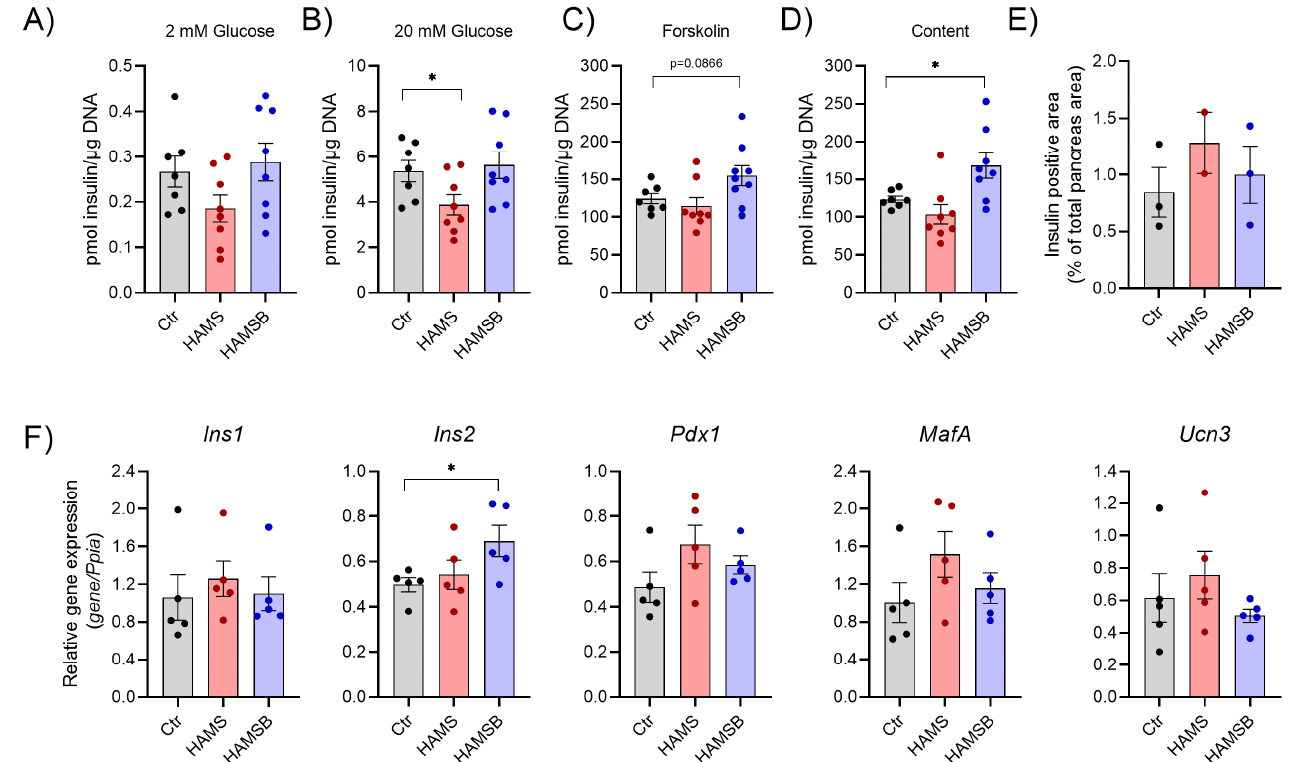
Figure 5. Islet function and gene expression. Insulin secretion was measured from islets of db/db mice fed three different diets: Ctr, HAMS or HAMSB for 5 weeks. The day after islet isolation, insulin secretion was measured by static batch incubations in response to 2 mM glucose ( A ), 20 mM glucose ( B ) and 20 µ M forskolin with 20 mM glucose, and normalized to DNA ( C ). ( D ) Insulin content measured post-assay. ( E ) Beta-cell area was detected by immunohistochemistry and shown as the insulin-positive area, as a percentage of the total pancreas area. ( F ) Gene expression was determined by RT-qPCR in pancreatic islets cultured overnight. Total RNA was extracted from a pool of islets from 1–5 mice on the same diet. Relative mRNA abundances of the insulin genes: insulin 1 ( Ins1 ) and insulin 2 ( Ins2 ) and beta-cell identity genes: pancreatic and duodenal homeobox 1 ( Pdx1 ), MAF bZIP transcription factor A ( MafA ) and urocortin3 ( Ucn3 ) are shown. Data are normalized to the reference gene peptidylprolyl isomerase A ( Ppia ). Bars show the mean ± SEM. * p < 0.05. Each circle represents pools of islets from mice.